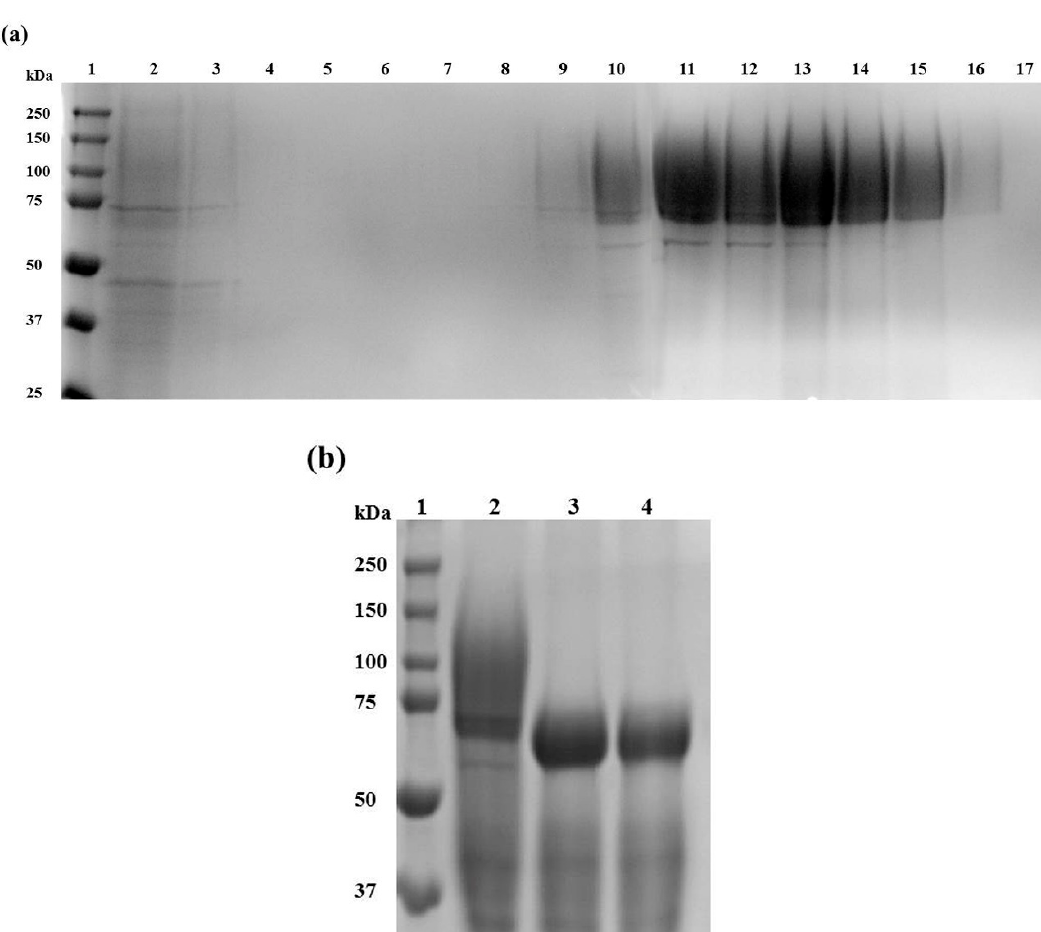
Figure 2. SDS-PAGE electrophoresis to evaluate ( a ) Af-EGL7 expression and purification. Lane 1: Molecular weight marker (Precision ™ Protein Standards Dual Color; BioRad, Hercules, CA, USA). Lane 2: Flow-through. Lanes 3–7: Fractions obtained after elution with 0 mM imidazole. Lanes 8–17: Fractions obtained after elution with 5, 10, 20, 40, 40, 80, 80, 160, 250, and 500 mM imidazole. ( b ) Af-EGL7 deglycosylation. Lane 1: Molecular weight marker (Precision ™ Protein Standards Dual Color; BioRad). Lane 2: Untreated purified Af-EGL7. The target protein is located with an estimated mass of 70 kDa. Lane 3 and 4: Af-EGL7 after Endo H treatment under non-denaturing and denaturing conditions, respectively. Both deglycosilation reactions produced a purified protein with approximately 60 kDa.